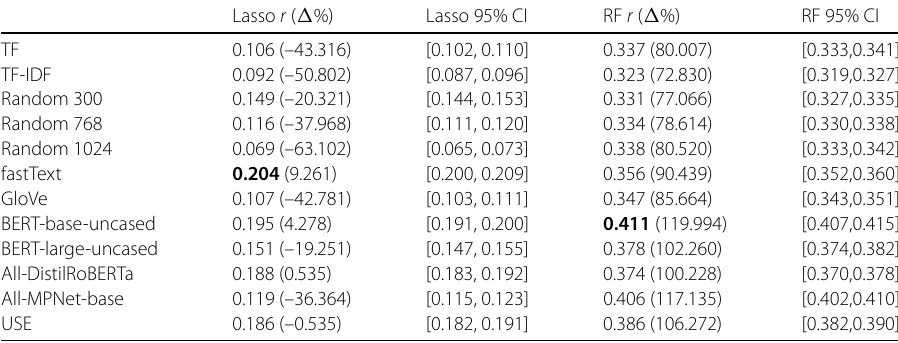
Table 4 Results of the Predictive Validity Analysis. r is the average Pearson’s correlation between predicted and observed scores. (cid:3) % in the parentheses indicates the percentage change in r in comparison to the baseline r : 0.187. 95% CI refers to the 95% confidence interval around r Lasso r ( (cid:3) %) Lasso 95% CI RF r ( (cid:3) %) RF 95% CI TF 0.106 (–43.316) [0.102, 0.110] 0.337 (80.007) [0.333,0.341] TF-IDF 0.092 (–50.802) [0.087, 0.096] 0.323 (72.830) [0.319,0.327] Random 300 0.149 (–20.321) [0.144, 0.153]